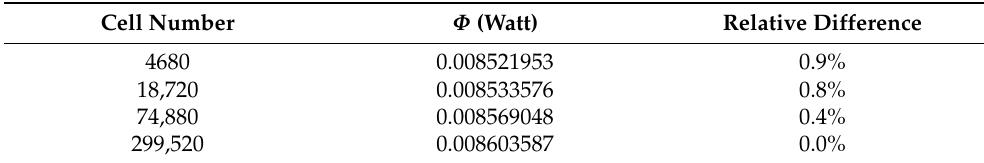
Table 1. Mesh sensitive study for the simulation of